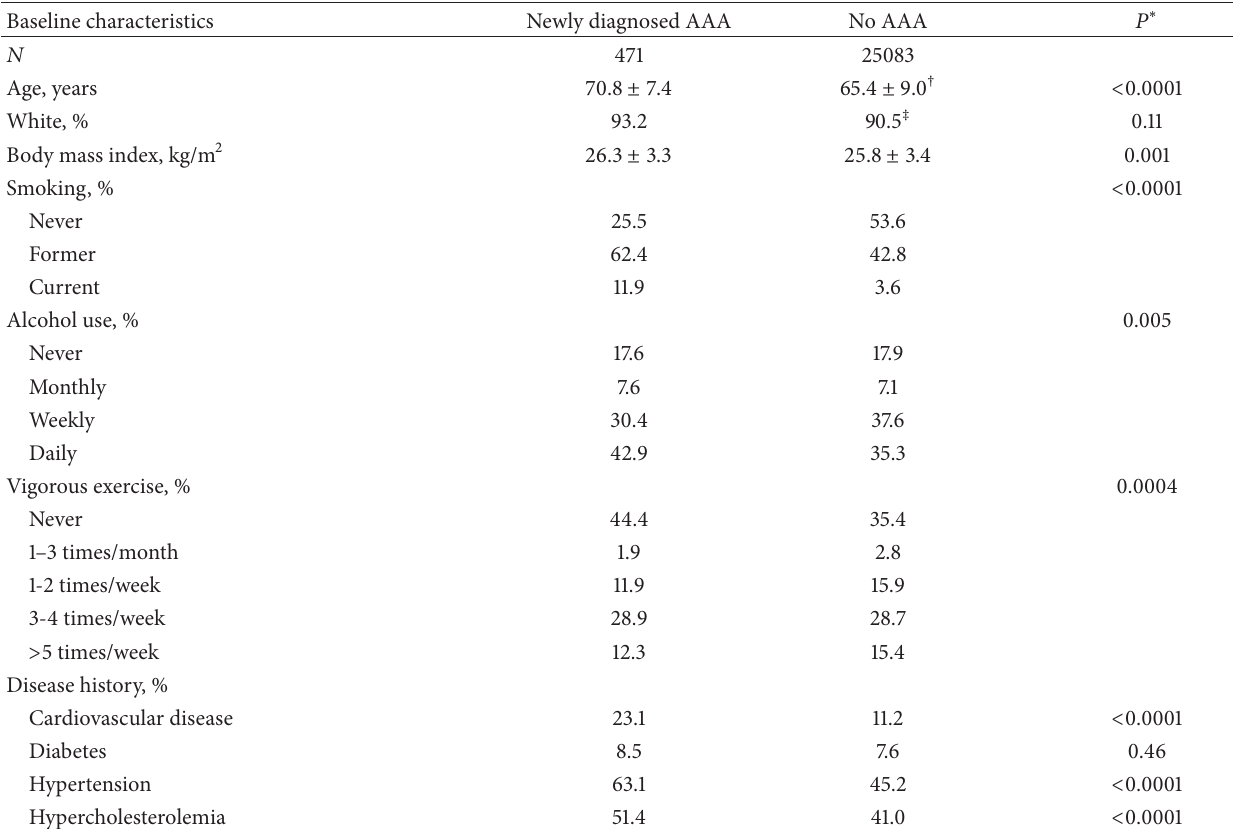
Table 1: Baseline characteristics of men who had versus who did not have newly diagnosed abdominal aortic aneurysm (AAA) during a mean of 10.4 years’